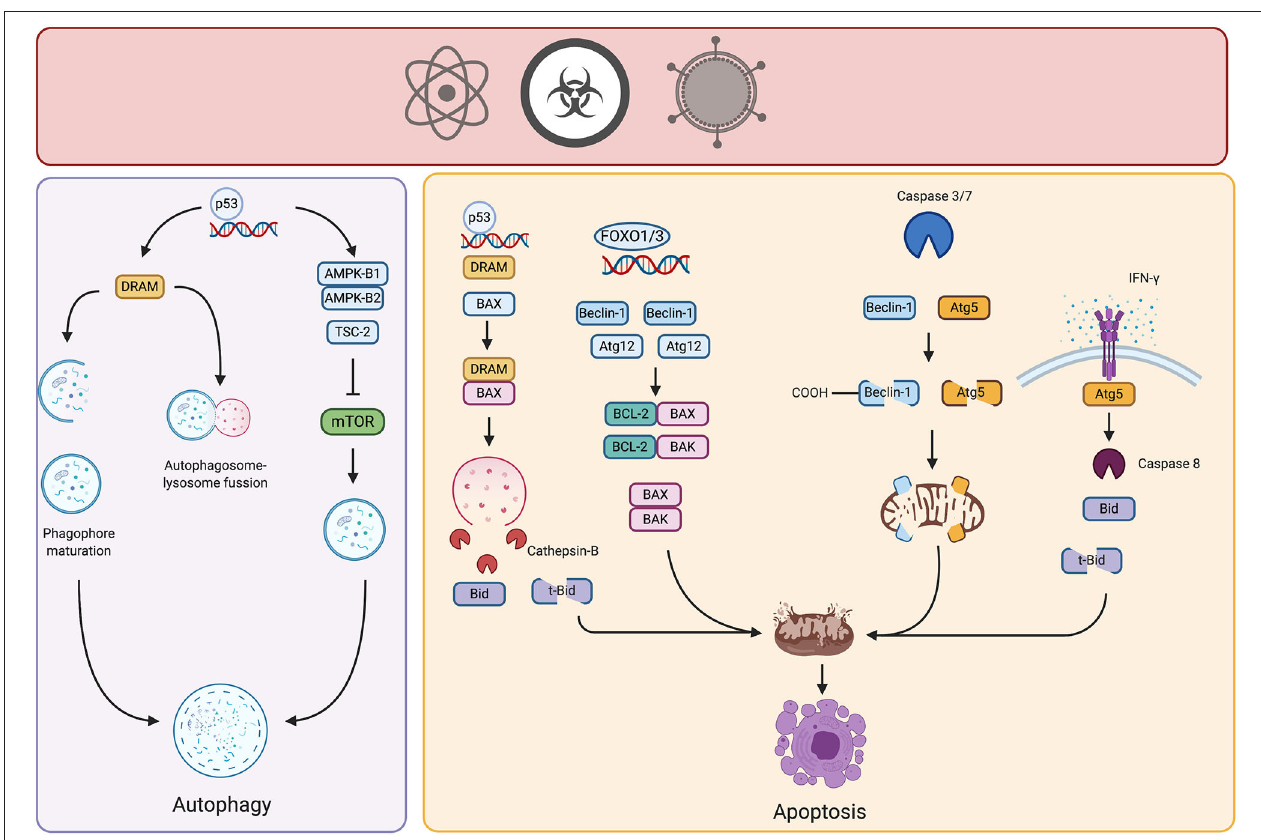
FIGURE 2 | Crosstalk of autophagy and apoptosis in cancer. Potential carcinogenic agents induce distinct types of stress in cell, triggering autophagy or apoptosis. Under certain threshold of damage, stress-responsive transcription factors such as p53 or FOXO promote the upregulation of genes involved in control and activation of autophagy, thereby neutralizing the damage. However, if the carcinogenic stimulus persists and damage is above threshold, autophagic proteins interact with pro- or anti- apoptotic molecules triggering intrinsic or extrinsic apoptosis, therefore limiting the growth of incipient tumor cells. Created by